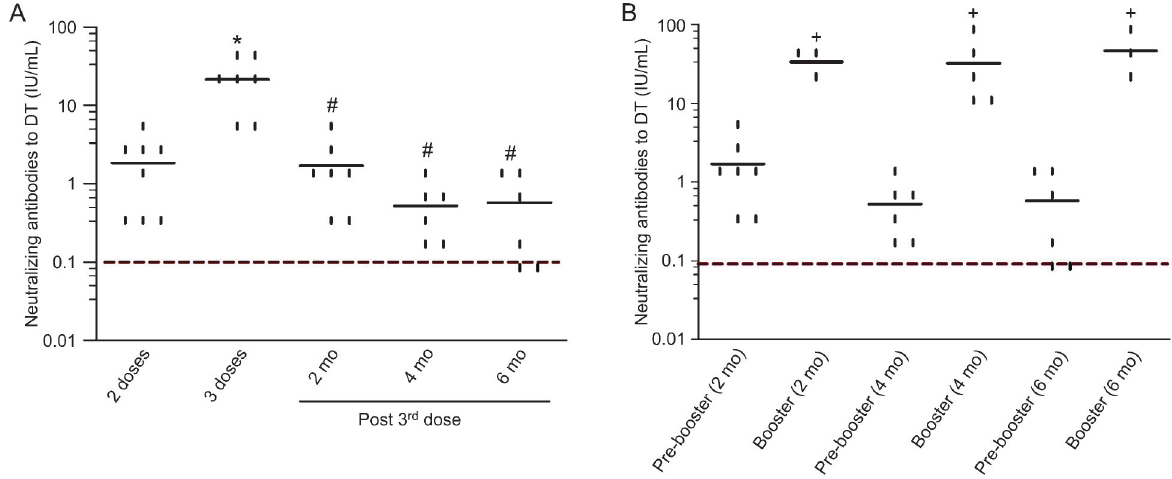
Figure 3. Neutralizing antibody levels to diphtheria toxoid (DT) of mice immunized with the diphtheria-tetanus-pertussis (DTP) vaccine. The lines show the average antibody titers detected at ( A ) 14 days after each vaccine injection during the primary immunization schedule and ( B ) before (pre-booster) and 14 days after boosting at 2, 4, and 6 months (mo) after the primary immunization schedule. The dashed line in A and B represents the protective neutralizing antibody level ( . 0.1 IU/mL). Points represent each individual antibody level, which was tested at least twice for each sample. *P , 0.05 compared to 2 doses. # P , 0.05 compared to 3 doses. + P , 0.05 compared to pre-booster. The paired t -test was used for statistical